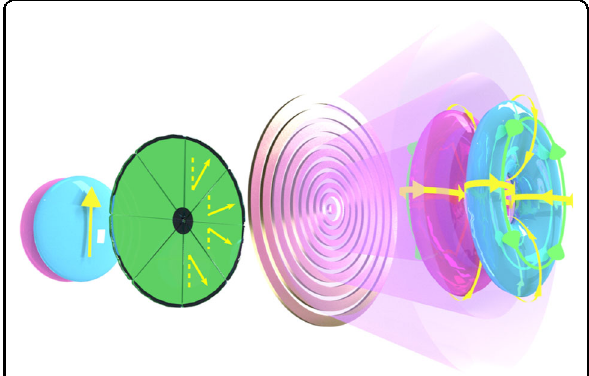
Fig. 1 Crafting toroidal light. A conventional linear polarized fi eld is fi rst converted into a radially polarized beam, with the electric fi eld pointing radially outwards, as depicted by the yellow arrows. This is passed through a metasurface comprising gold rings of varying width, narrower near the center and increasing in width towards the rim. The radially polarized light sees this as a 1D grating, with the resulting toroidal response leading to toroidal pulses of light: doughnut-shaped pulses with looping electric (yellow) and magnetic (green) fi elds. Image courtesy of the University of